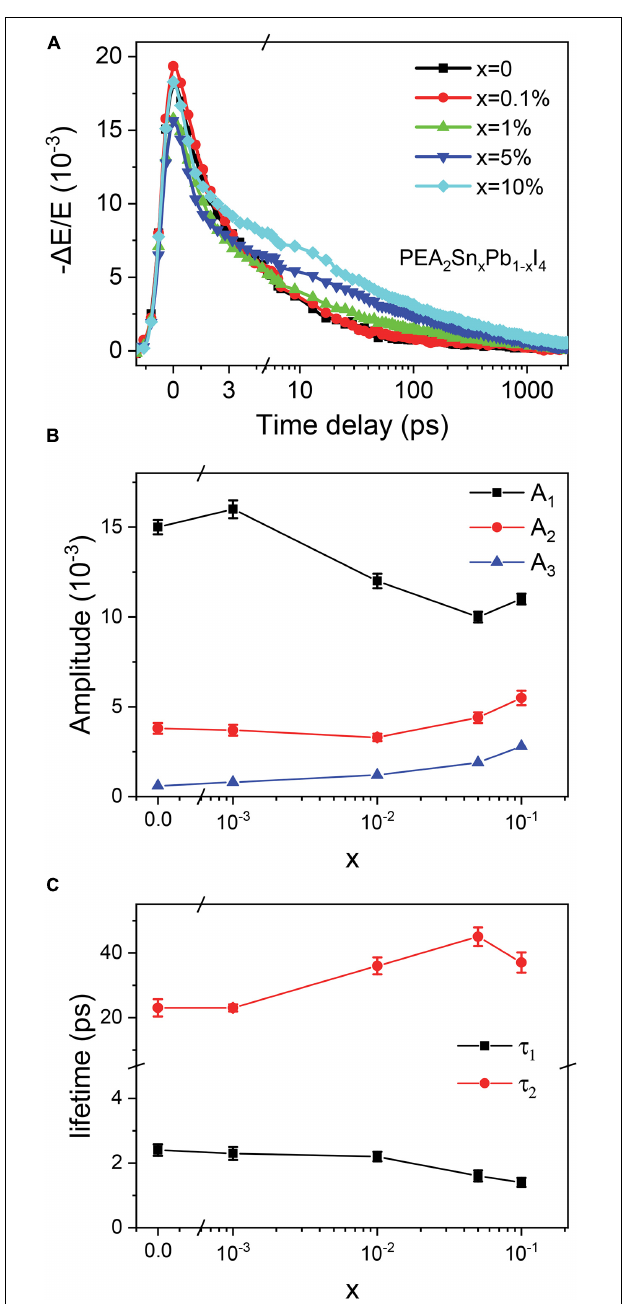
FIGURE 2 | Doping-level-dependent charge carrier dynamics in Sn-doped PEA 2 PbI 4 perovskite samples. (A) The traces of OPTP decay dynamics recorded from the samples with different doping levels at room temperature with pump of 50 µ J/cm 2 . The fitting parameters of amplitudes (B) and lifetimes (C) derived from the tri-exponential decay function are plotted vs. the doping